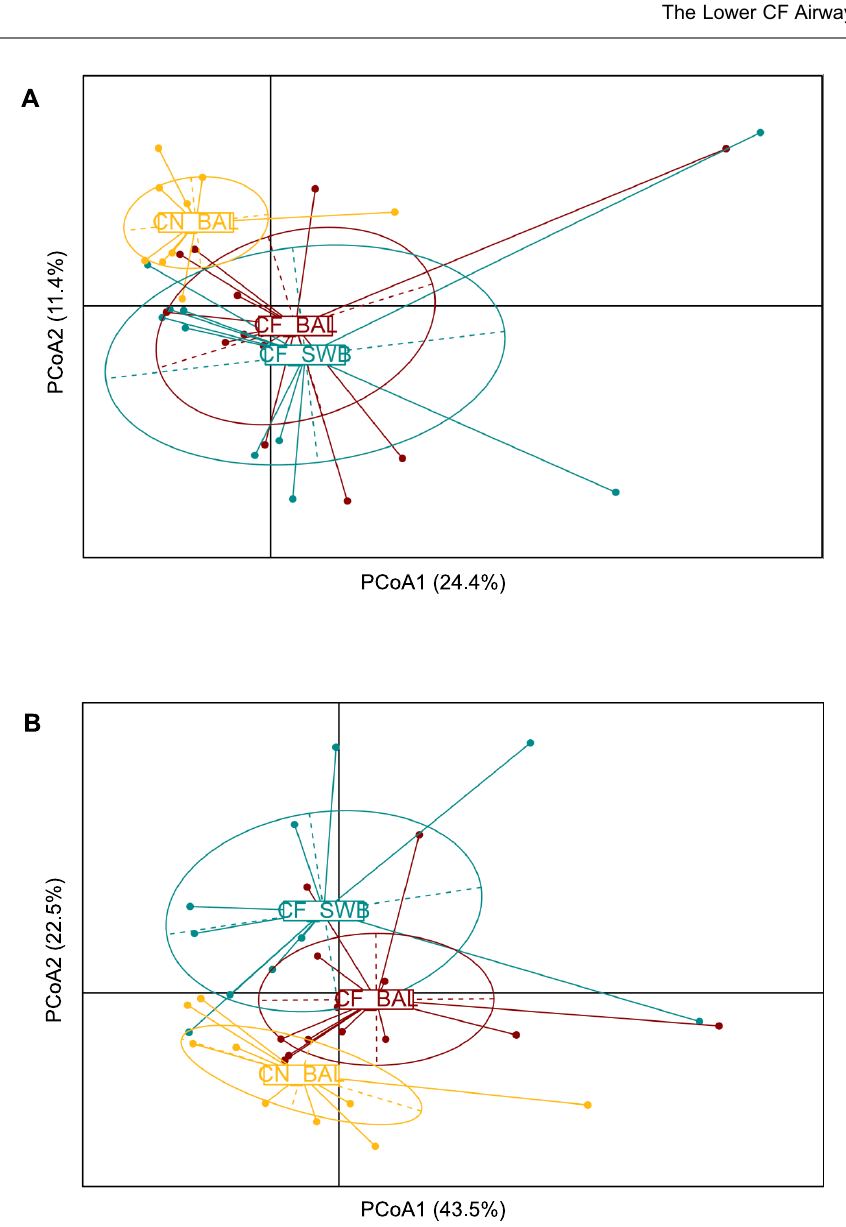
Fig. 2. Bacterial community structures in the control lower airways and the CF upper and lower airways. Principle coordinate analysis (PCoA) plots of A) UniFrac distances and B) weighted UniFrac distances of all airway microbial communities were created in R. Each community from each sample is represented as a filled circle and coloured by sample type and/or patient cohort; CF lower (CF BAL; red), CF upper (CF SWB; blue) and control lower (CN BAL; yellow) airway samples. The x-axis and y-axis represent 2- dimensions of percentage variation explained by the PCoA. Ellipses were included for visualisation